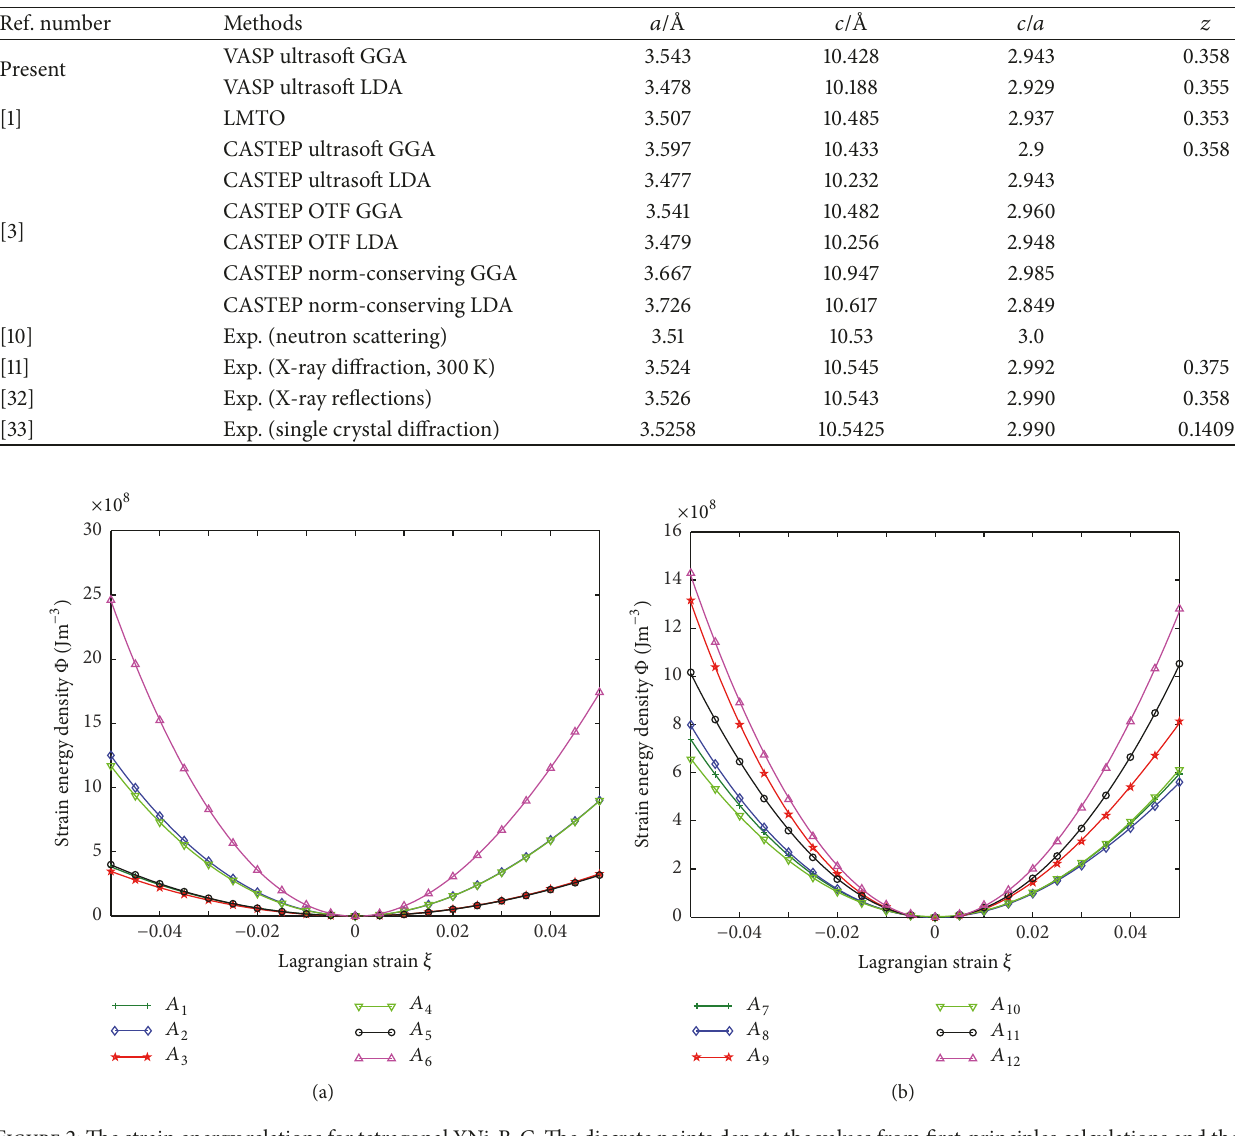
Figure 2: The strain energy relations for tetragonal YNi 2 B 2 C. The discrete points denote the values from first-principles calculations and the solid curves represent the results obtained from the third-order polynomial